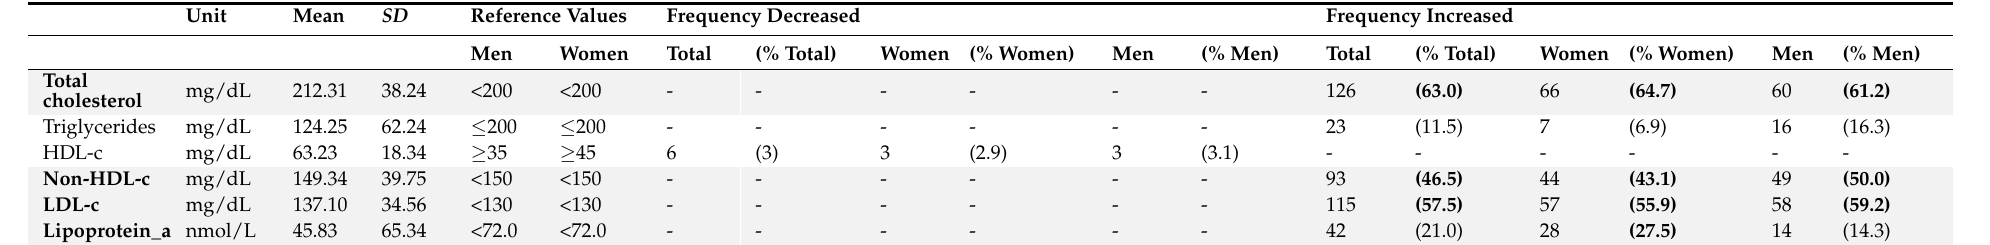
Table 4. Frequency rates of participants with increased or decreased vascular-metabolic blood parameters. Indices with ‘outstanding’ rates of ≥ 25% are highlighted for emphasis.